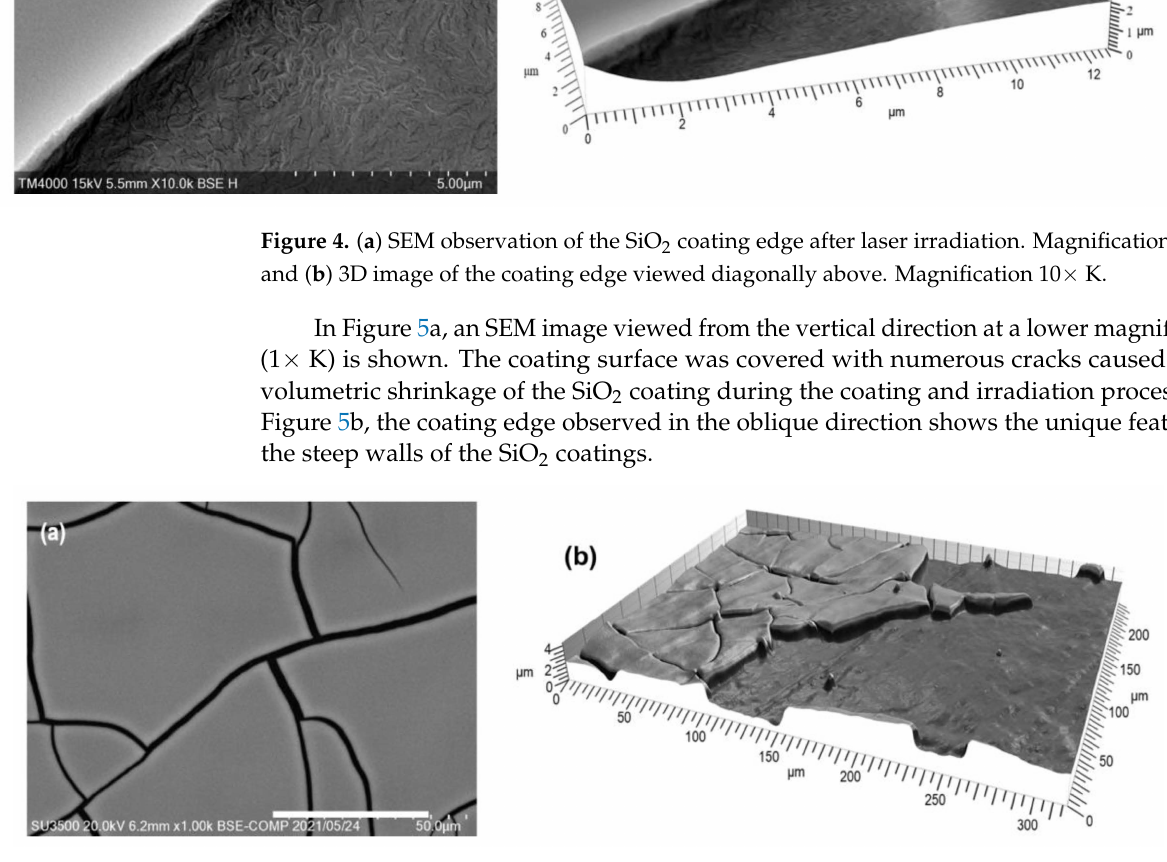
Figure 5. ( a ) SEM observation of the SiO 2 coating surface on UHMWPE. Magnification 1 × K, and ( b ) 3D view of the coating edge. Magnification 1 ×